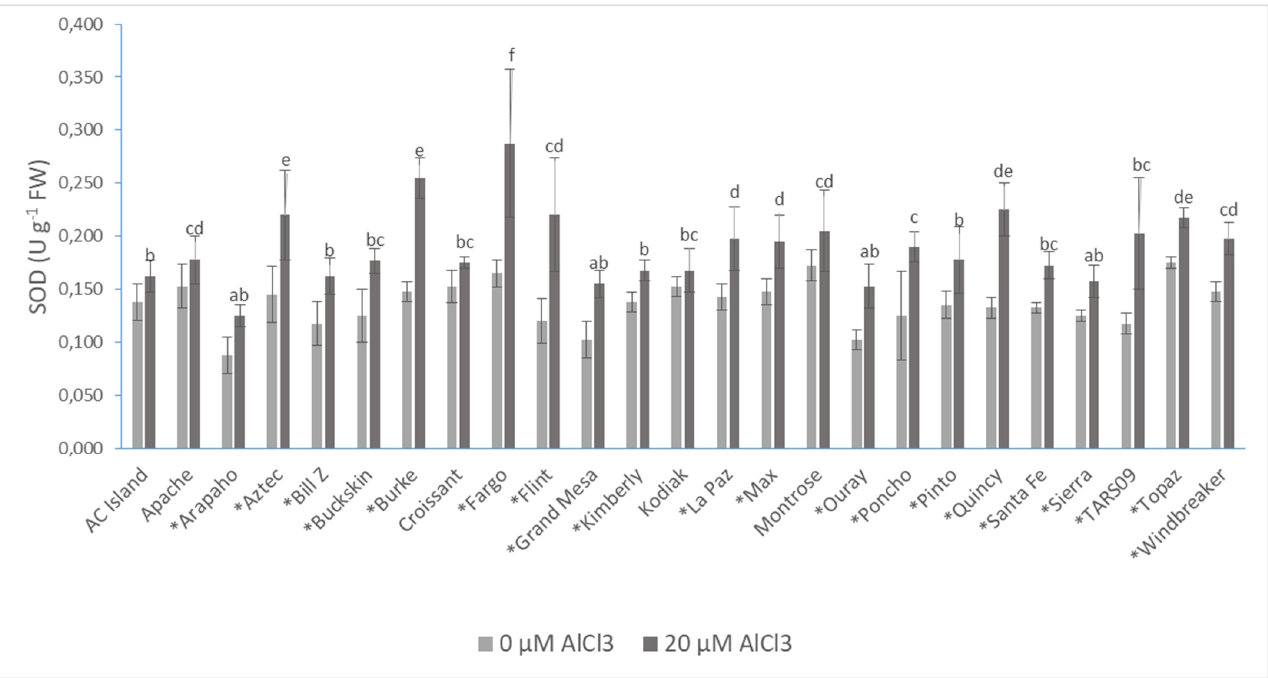
Figure 2. The superoxide (SOD) activity of 25 common bean cultivars 72 h after AlCl 3 treatment. Values are the averages of five biological and technical repetitions ± SD. * Significant difference between treatments based on Shapiro–Wilk test ( p ≤ 0.05). Lowercase letters denote a significant difference among the AlCl 3 -treated cultivars. FW: fresh weight.